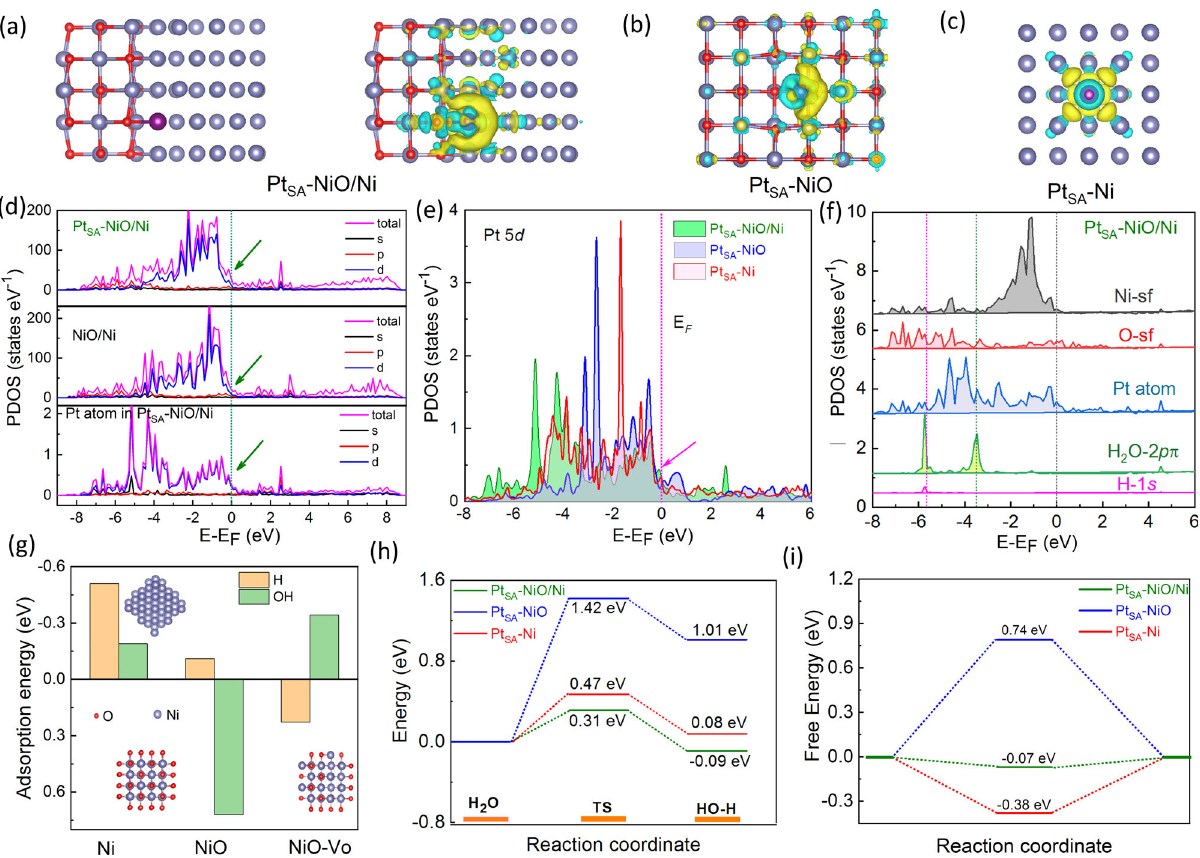
Fig. 4 Theoretical investigations. Computational models and localized electric fi eld distribution of a Pt SA -NiO/Ni, b Pt SA -NiO, and c Pt SA -Ni. d Calculated PDOS of NiO/Ni and Pt SA -NiO/Ni, with aligned Fermi level. e Calculated Pt 5 d band of Pt SA -NiO/Ni, Pt SA -NiO, and Pt SA -Ni. f The orbital alignment of the sur fi cial sites for Pt SA -NiO/Ni binding with H 2 O molecule. g Calculated OH-binding energies ( Δ E OH ) and H binding energies ( Δ E H ) for Ni, pure NiO, and O vacancies-modi fi ed NiO surface. h Calculated energy barriers of water dissociation kinetic and i adsorption free energies of H* on the surface of the Pt SA -NiO/Ni, Pt SA -NiO, and Pt SA -Ni catalysts,